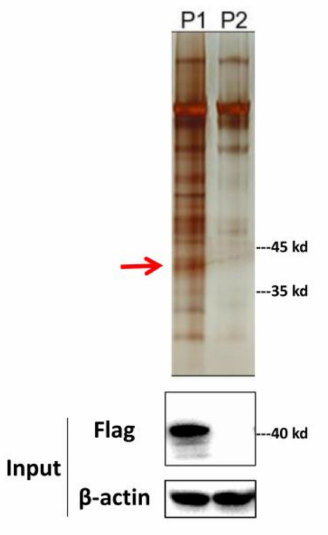
Figure 1. Western blotting and silver staining were used to detect the expression of exogenous MGF360-9L in PK-15 cells and the enrichment of MGF360-9L interacting proteins. Empty FLAG vector (8 µ g) or FLAG-MGF360-9L (8 µ g) was transfected into PK-15 cells. FLAG monoclonal antibody was used for pull down 24 h after transfection. MGF360-9L-interacting host proteins were eluted with protein A/G sepharose and analyzed on SDS-PAGE followed by silver staining. β -actin was used as a loading control. Lane P1, MGF360-9L protein complex, the MGF360-9L protein is represented by a red arrow; Lane P2, empty FLAG control. The data were tested three times